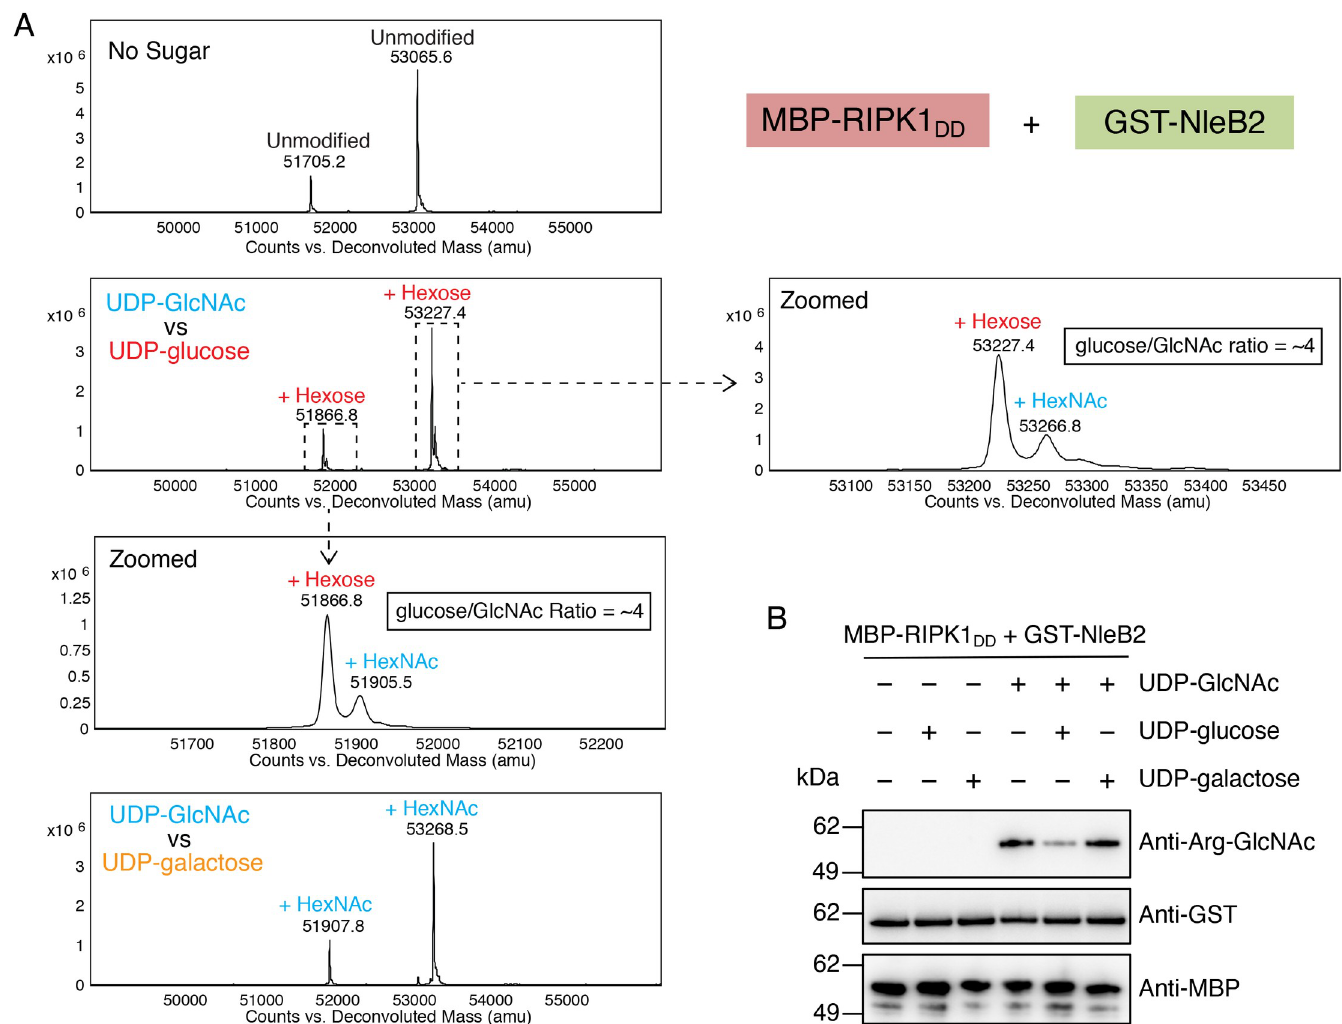
Fig 4. Preference of NleB2 for UDP-glucose in vitro . (A) Deconvoluted intact mass spectra of in vitro sugar donor competition assays. MBP-RIPK1 DD was incubated with GST-NleB2 without sugar donors, or in the presence of UDP-GlcNAc and either UDP-galactose or UDP-glucose at 25 μ M concentrations of each sugar donor. (B) In vitro sugar donor competition assays. MBP-RIPK1 DD was incubated with GST-NleB2 without sugar donors, or in the presence of 25 μ M UDP-glucose, UDP- galactose or UDP-GlcNAc individually or in combination. Proteins were subjected to PAGE and immunoblot with anti-ArgGlcNAc, or anti-MBP and anti-GST antibodies as controls. Representative of at least 3